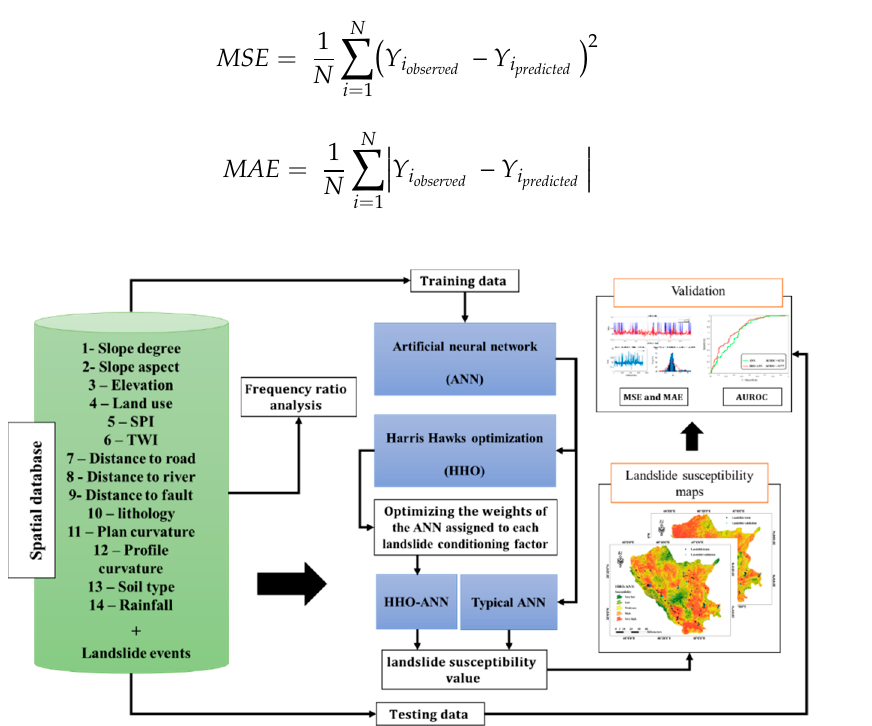
Figure 3. Applied procedure for landslide susceptibility assessment of this study.